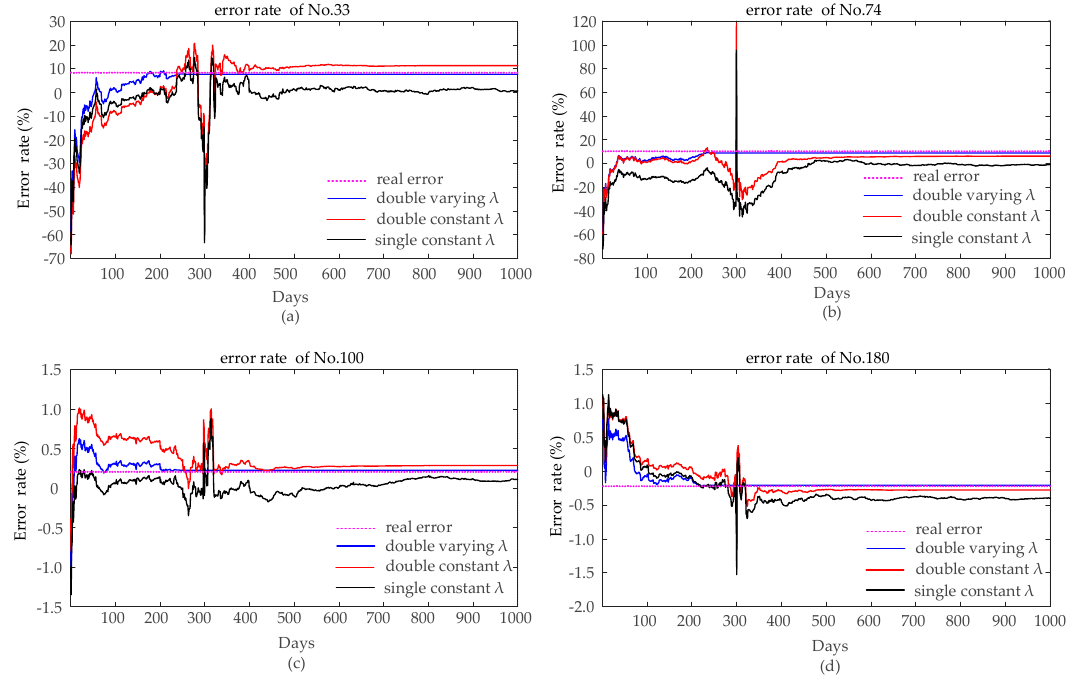
Figure 5. The operational error recursive estimation curves: ( a ) represents the error rate recursive estimation curve of No.33 electric meter; ( b ) represents the error rate recursive estimation curve of No.74 electric meter; ( c ) represents the error rate recursive estimation curve of No.100 electric meter; ( d ) represents the error rate recursive estimation curve of No.180 electric meter.